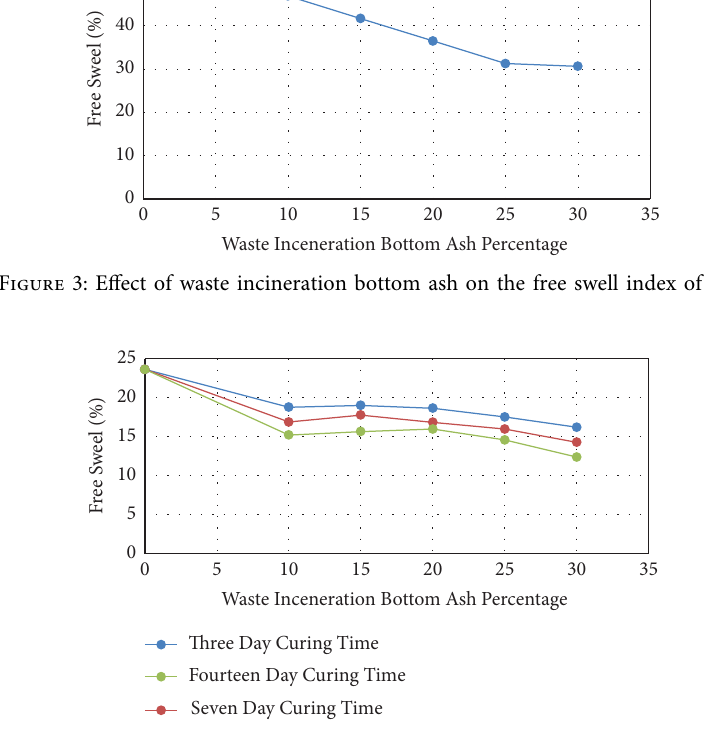
Figure 4: Efect of waste incineration bottom ash content and curing period on optimum moisture content of subgrade soil.